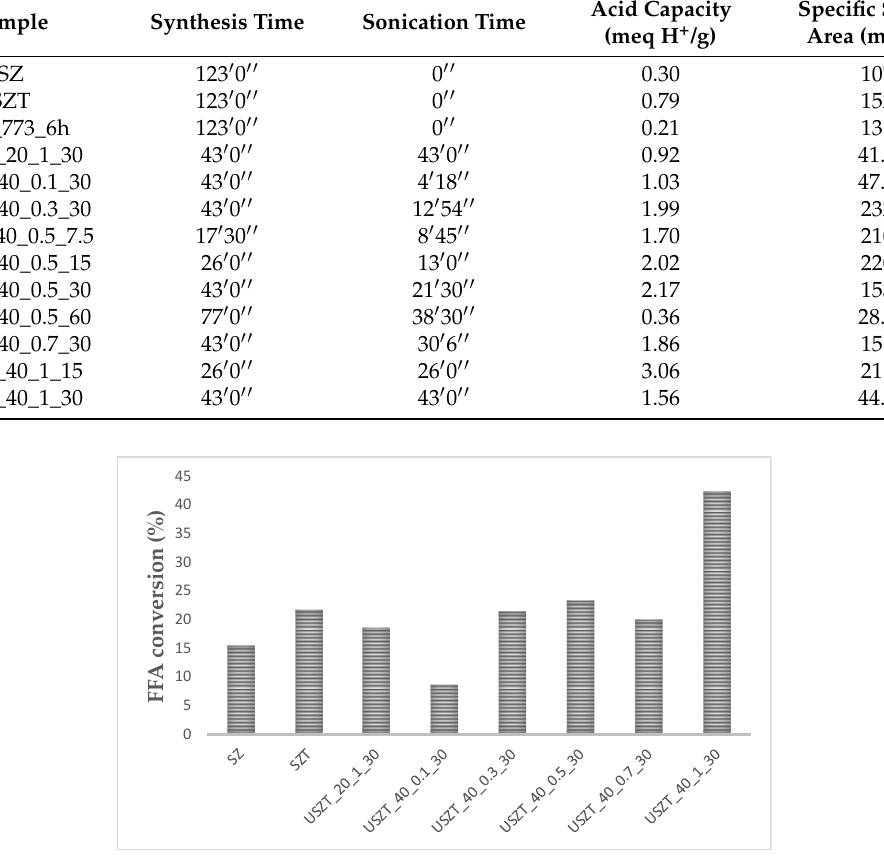
Figure 6. Conversions obtained after 6 h of reaction, 336 ± 2 K, slurry reactor, initial acidity: 7.5 wt.% (oleic acid), MeOH:oil = 16:100 wt, catalyst:oleic acid = 5:100 wt. Table 5. List of all samples and of employed synthesis parameters (maximum power = 450 W).